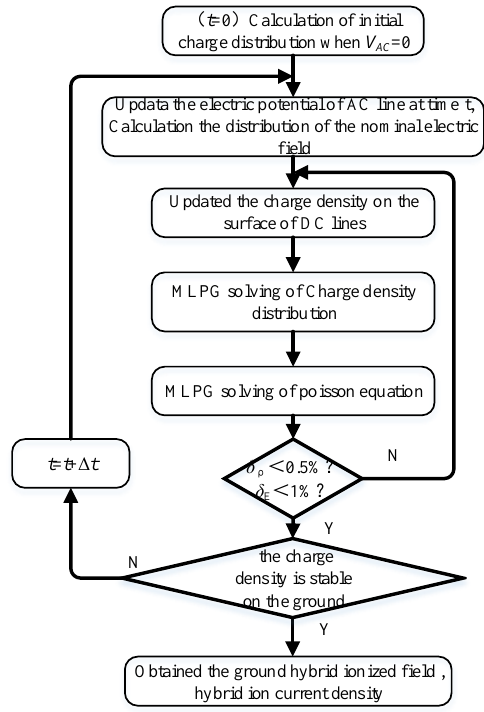
Figure 3. Computational modeling flowchart based on MLPG method.